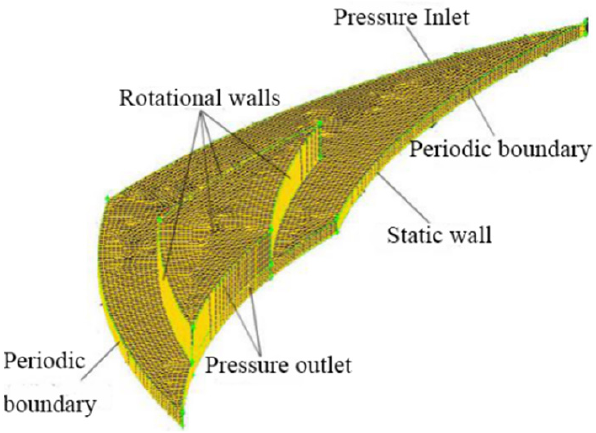
Figure 3. Grid independence validation.